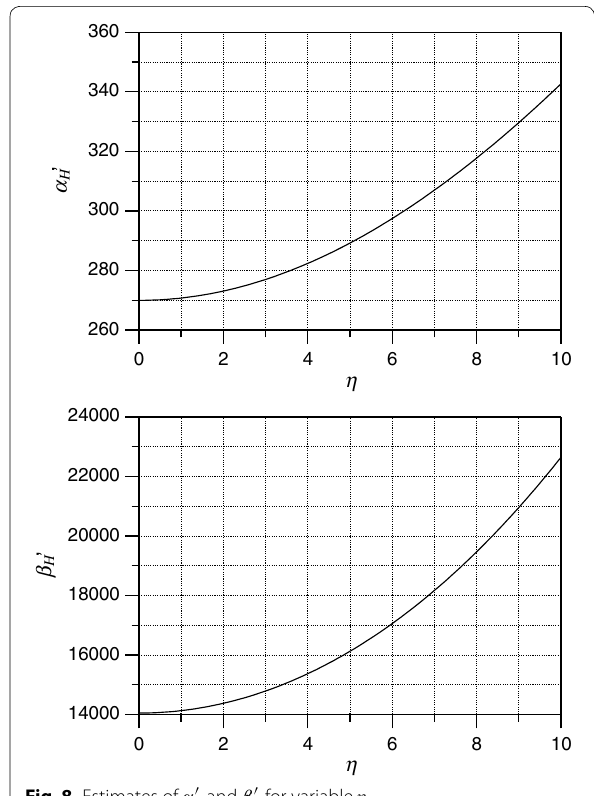
Fig. 8 Estimates of α ′ H and β ′ H for variable